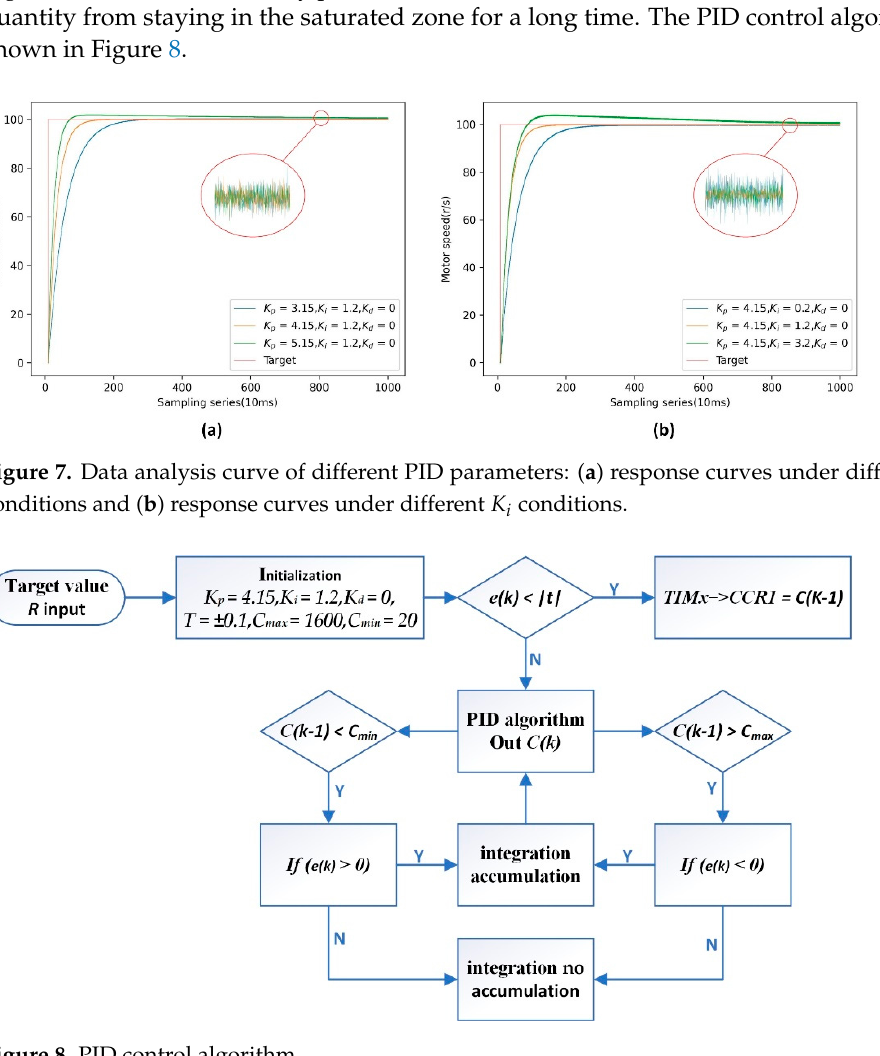
Figure 8. PID control algorithm.